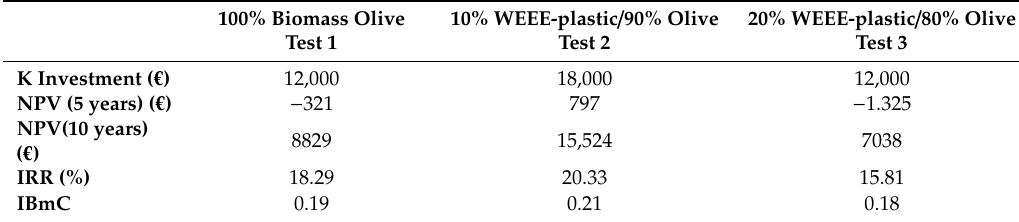
Table 16. Comparative results of the analysis of economic indicators (Source: